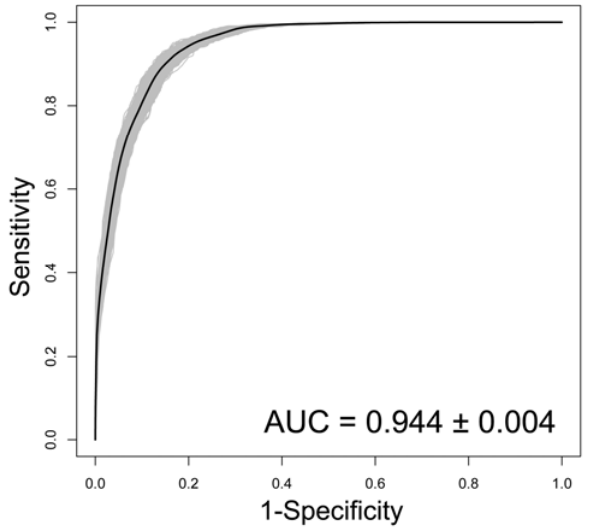
Figure 2. ROC curves of the predictive power of the multiple logistic regression models on the risks of bacillary dysentery in southwest China. (Gray lines: ROC curves of the 1000 fitted models; Black line: mean ROC curve of the 1000 fitted models). Table 4. Accuracy assessment based on independent validation samples.